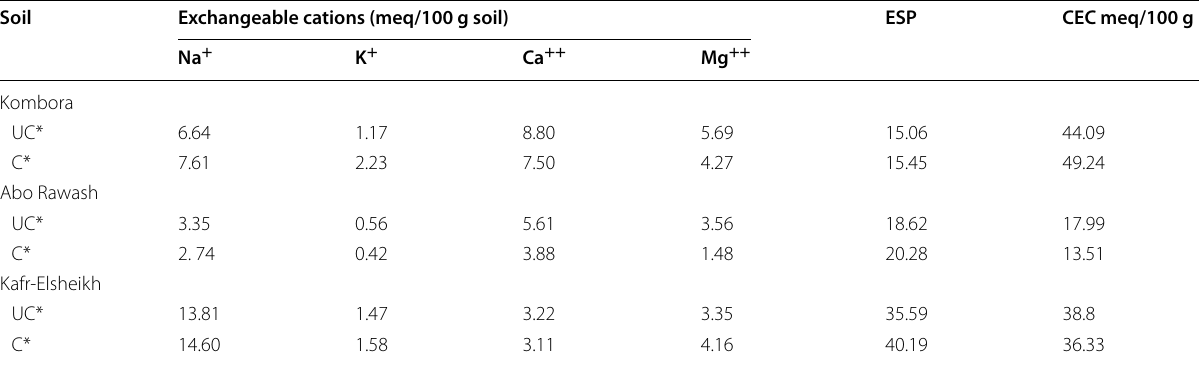
Table 8 Exchangeable cations and exchangeable sodium percent in the soil profile as influenced by irrigation water quality